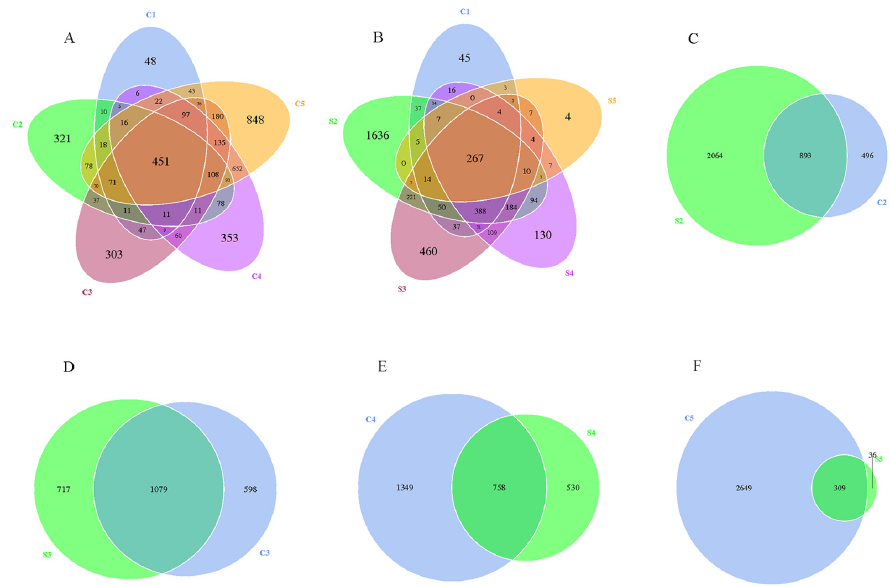
Figure 2. Venn diagram representing shared operational taxonomic units (OTUs) between samples from the control group and the treatment group of silver pomfret taken at different times. ( A ) con- trol group, from C1 to C5; ( B ) treatment group, from S1 to S5; ( C ) C2 vs. S2; ( D ) C3 vs. S3; ( E ) C4 vs. S4; ( F ) C5 vs. S5. ( F ) C5 vs. S5.